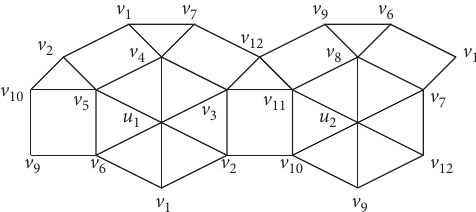
Figure 5: Doubly semiequivelar maps on Klein bottle of type K 1(2,12) [3 6 : 3 2 , 4, 3, 4].